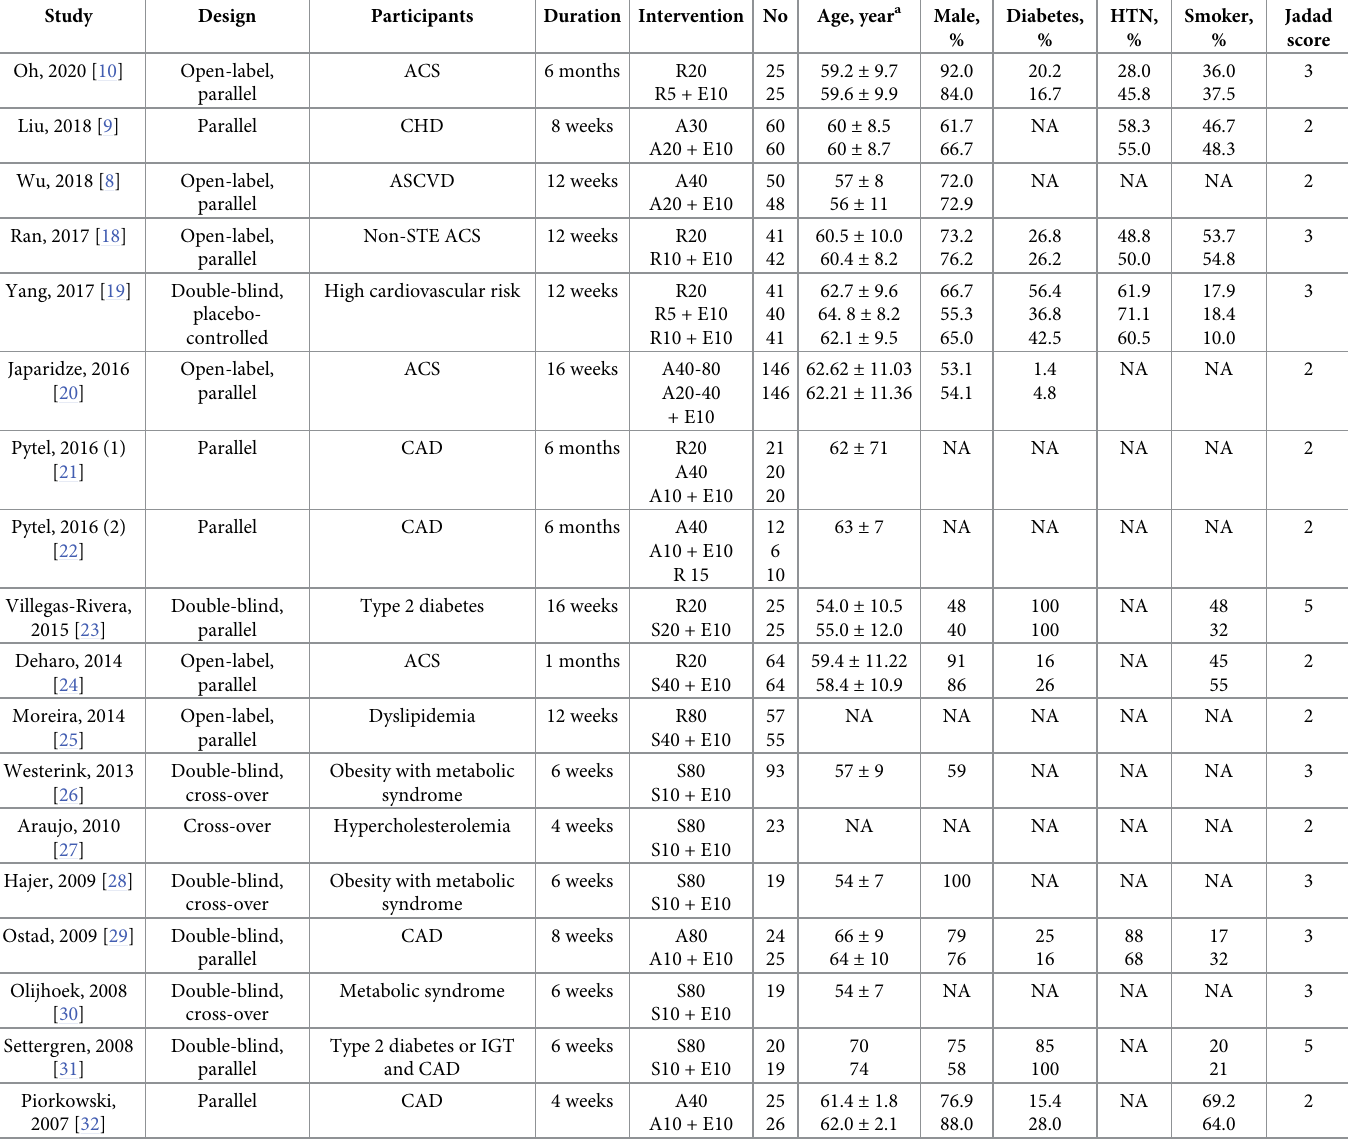
Table 1. General characteristics of the included studies for meta-analysis.